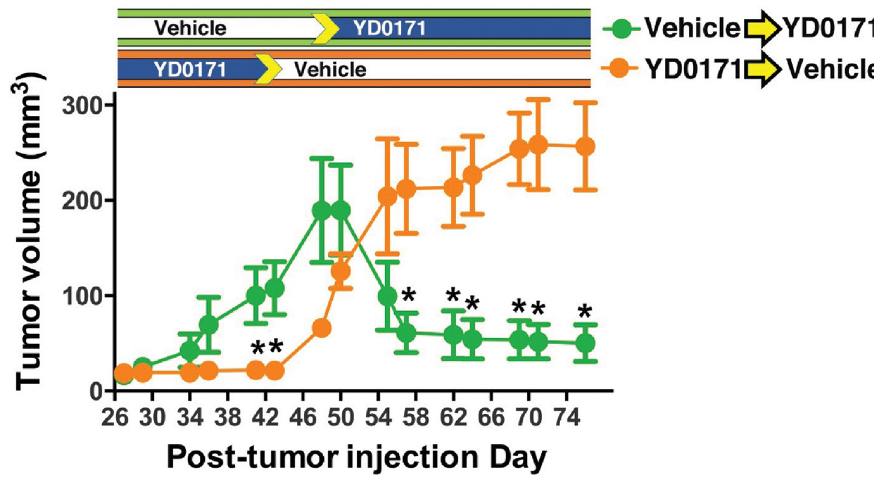
Figure 17. YD0171 induces HCT116 tumor regression in nude mice. Mice were subjected to implantation of HCT116 tumors. When a small palpable tumor was evident at 7 d, the mice were randomized into a vehicle-treated group and a group treated with YD0171 (3 mg/kg/d). In the YD0171-treated animals, treatment discontinued on d 42. In vehicle-treated animals, on d 50, treatment with YD0171 commenced. Pretreatment with YD0171 at the onset of the study prevented the growth of the tumors; discontinuation of the YD0171 treatment allowed tumor growth to commence. Data are shown as mean ± SEM of n = 8 animals per group; * p < 0.05 and ** p < 0.01 indicate a significant inhibitory effect of YD0171 compared with the corresponding vehicle control at the same time